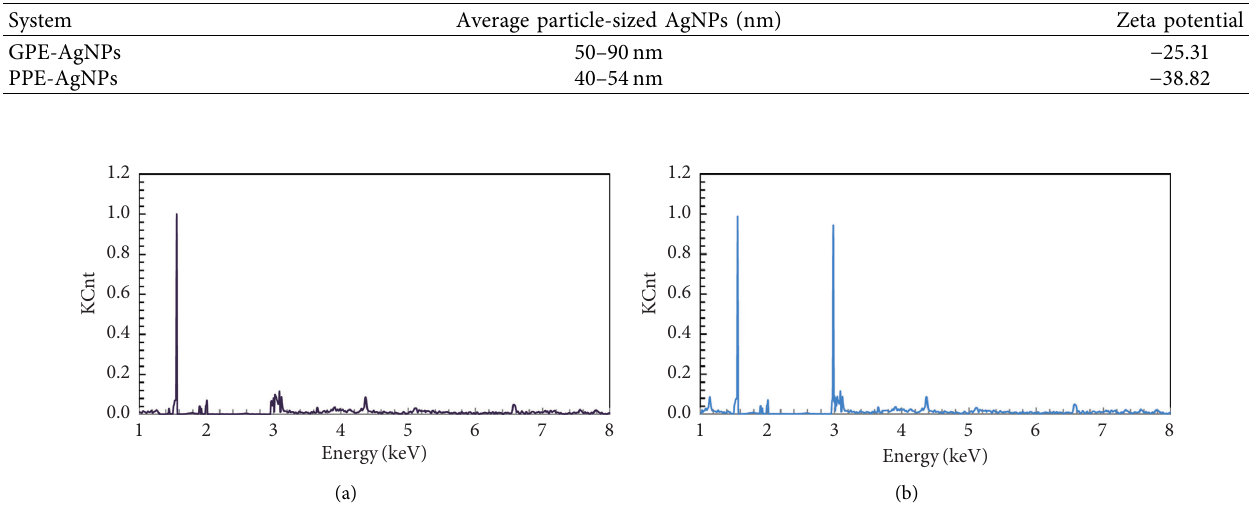
Figure 9: EDX spectra of GPE-AgNPs and